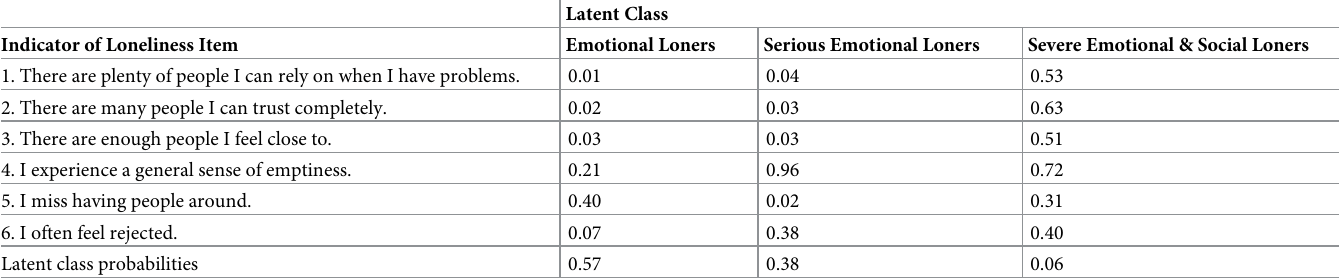
Table 2. Latent class cluster models for conditional probabilities for the three-cluster model of loneliness among young adults.